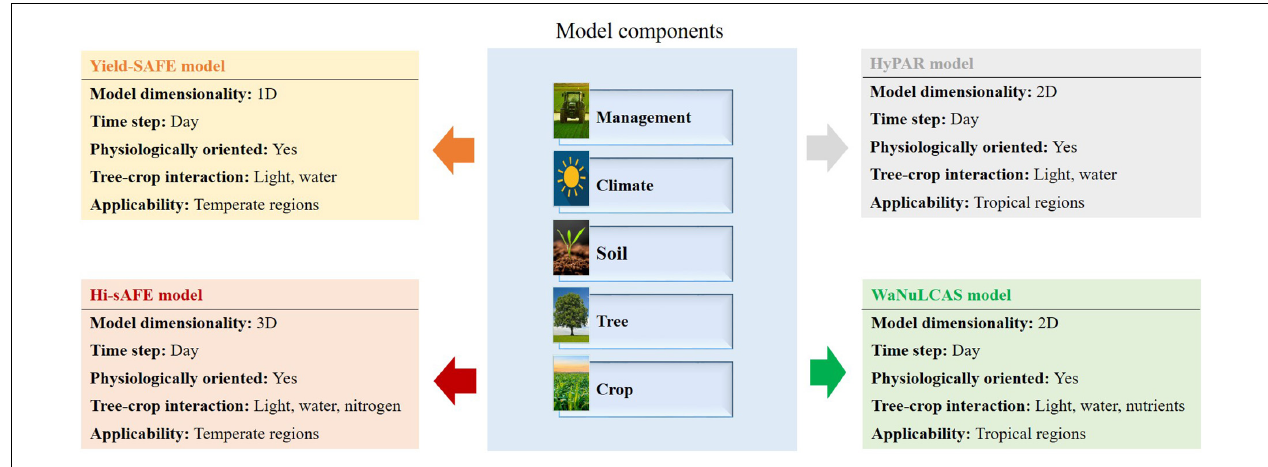
FIGURE 1 | Overview of the most used agroforestry models, in relation to model components, model dimensionality, time steps, integration of physiological process, tree–crop interactions, and